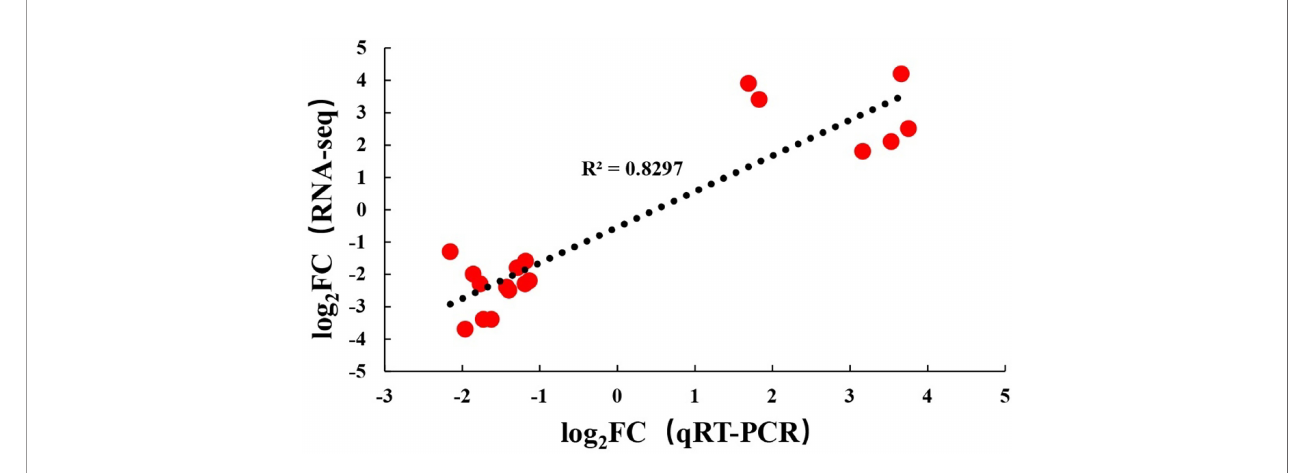
FIGURE 5 | Comparison of levels for 18 DEGs using RNA-Seq and